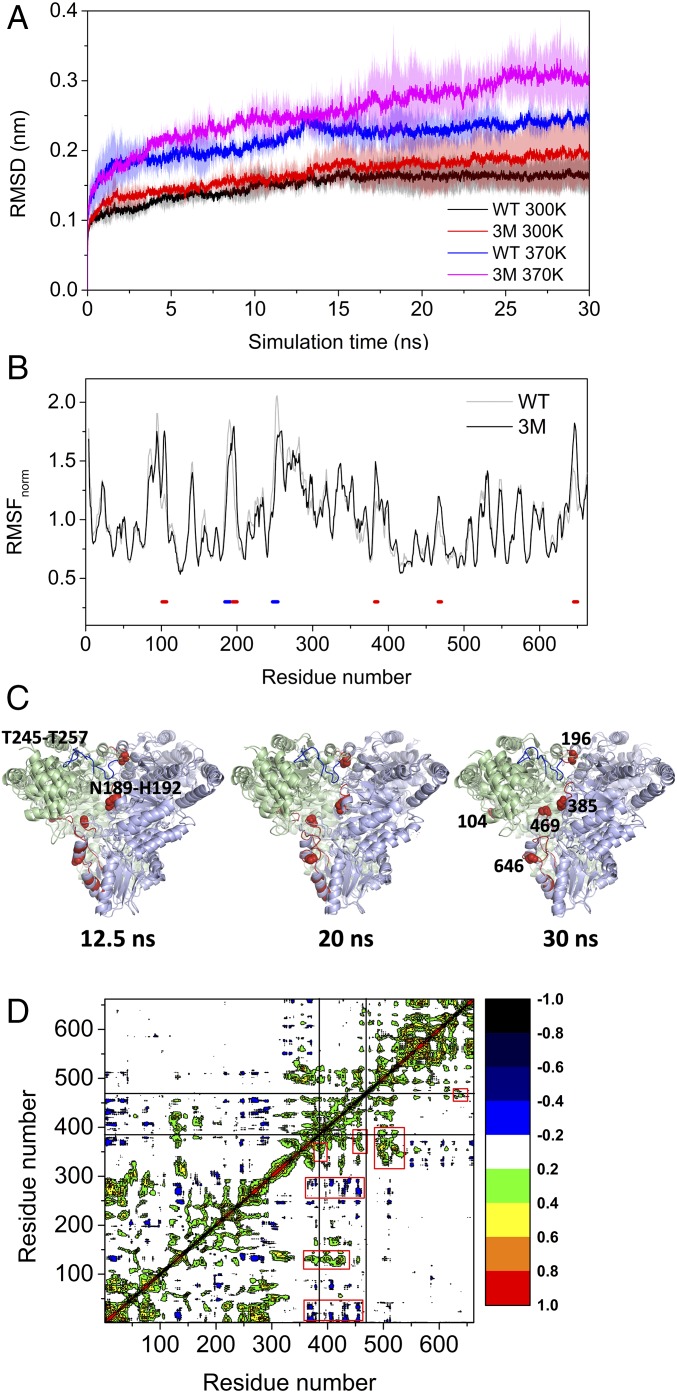
MD simulation analysis of 3M variant. (A) Comparison of RMSD values of WT and the 3M variant calculated from triplicate 30-ns MD simulations at 300 K and 370 K. (B) Comparison of normalized RMSF of WT and the 3M variant. Red, residues with ΔRMSF between variant and WT > 0.2; blue, residues with ΔRMSF < −0.2. (C) Structural alignment between WT and 3M at three key simulation timepoints. Light green, chain A; light blue, chain B; red, flexible regions in the 3M including G99-Y105, G195-D200, D381-N386, L466-G470, V630-K660; blue, regions stabilized in the 3M including N185-H192 and T245-T257. The five flexible residues in the 3M are shown as spheres. (D) DCCM for the 3M variant, based on the last 10-ns of the MD simulation trajectory at 370 K, and averaged from triplicate runs.